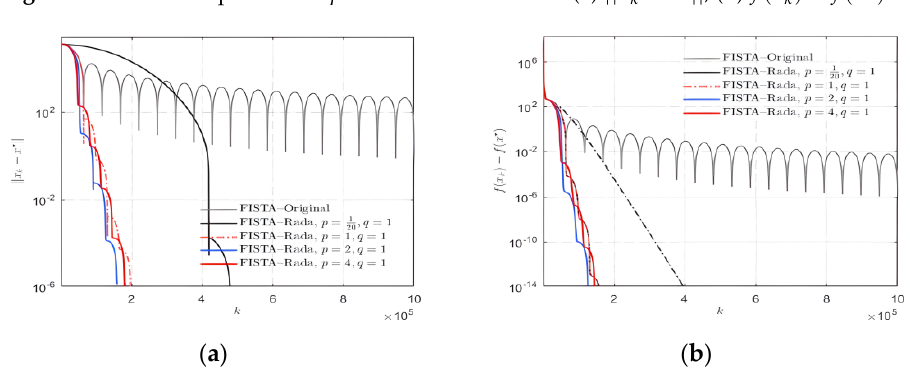
Figure 3. Selection of parameter q value for FISTA − Rada. ( a ) || x k − x ∗ || ; ( b ) f ( x k ) − f ( x ∗ ) .